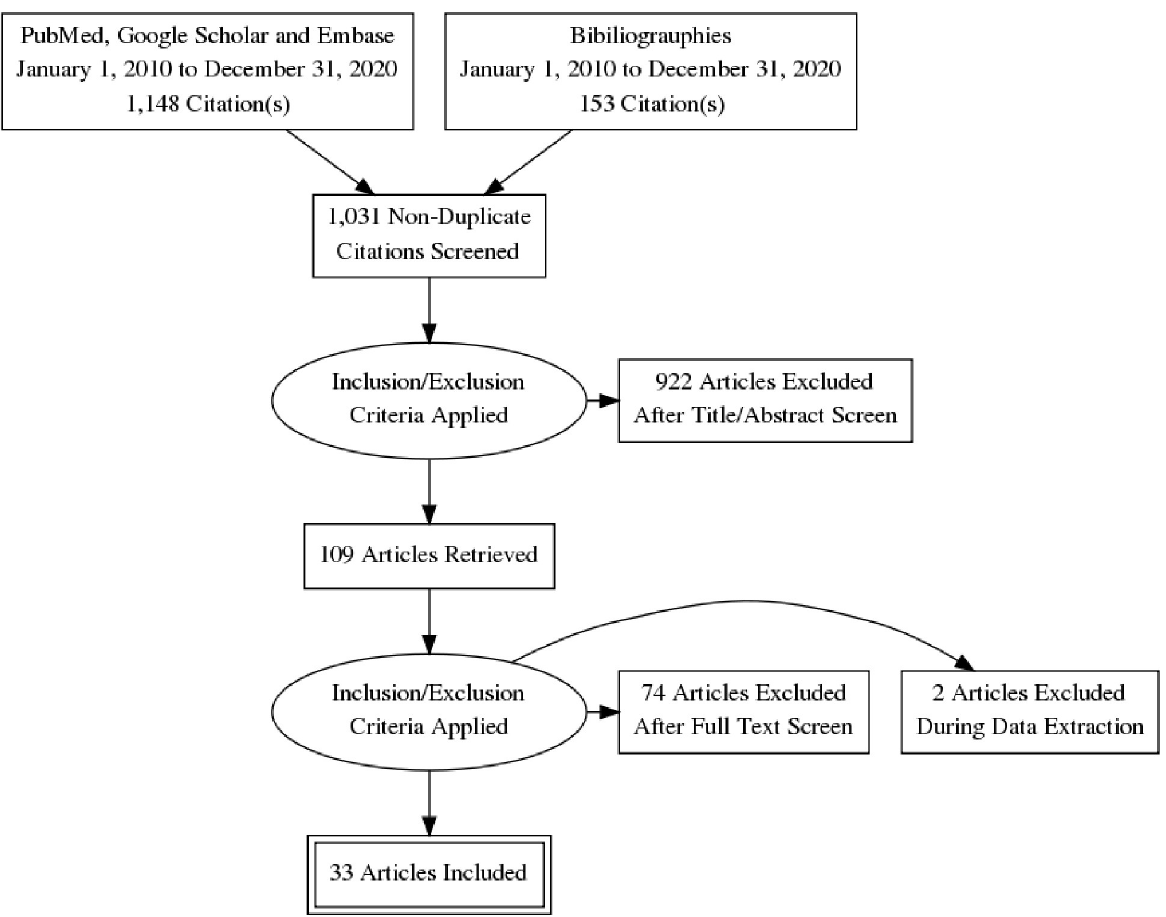
Fig 1. PRISMA flow diagram. Graphical representation of the flow of citations reviewed in the course of the systematic review and meta-analysis. Abbreviation: Preferred items for systematic review and meta-analysis (PRISMA).